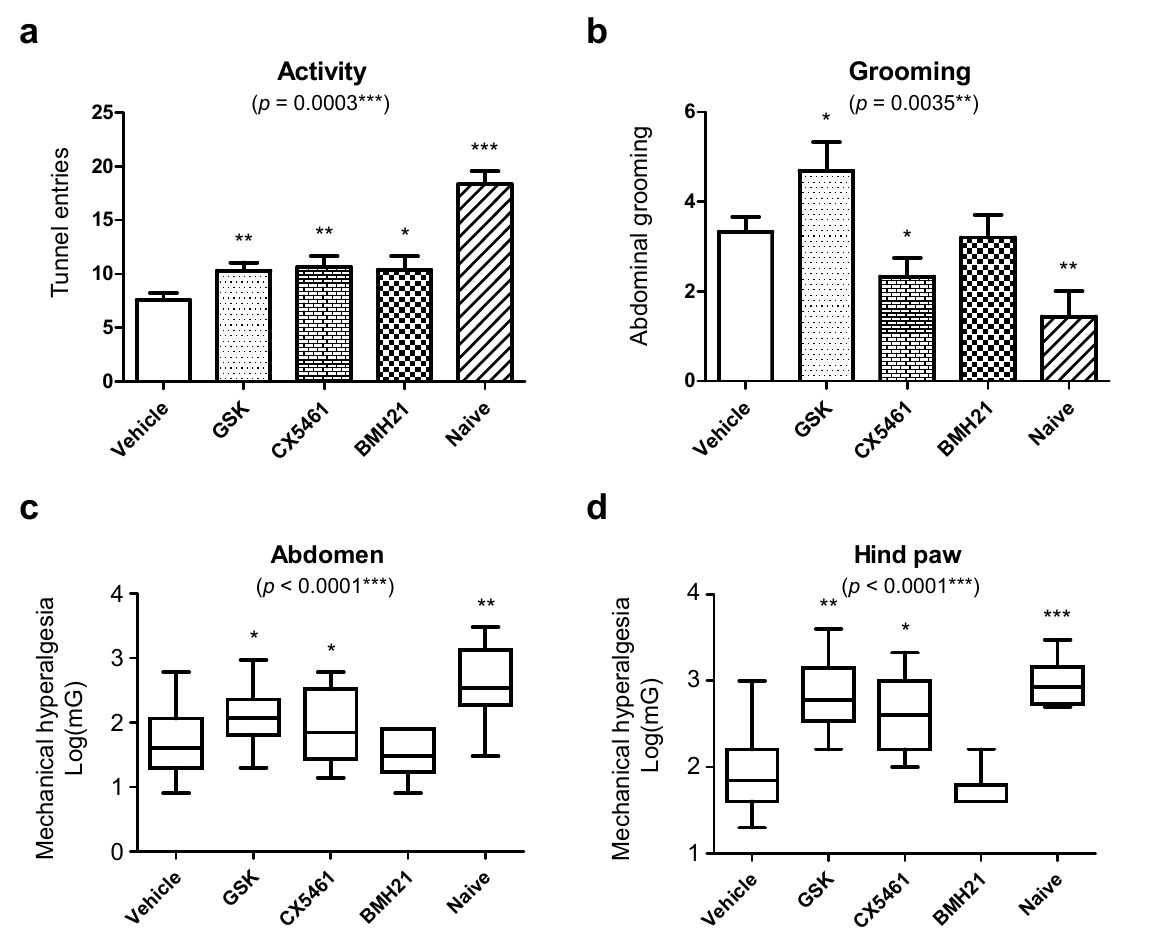
Figure 6. Impacts of anti-ribosome biogenesis agents on pain relief in endometriosis mice. The behavior study was performed to monitor ( a ) tunnel-entering activity and ( b ) abdominal grooming of disease mice treated with different drugs within five minutes. Touch test (von Frey) was also per- formed on ( c ) abdomen and ( d ) hind paws of mice to quantify pain-sensitivity. The vehicle-treated mice were utilized as the untreated controls whereas naïve mice were utilized as healthy controls. The data were averaged from three independent experiments ( n = 15 for each group). Statistical differences between vehicle and drug-treated groups were compared by using one-way ANOVA (Kruskal-Wallis) test. The p values were presented as *: p value < 0.05, **: p value < 0.01, and ***: p value < 0.001.